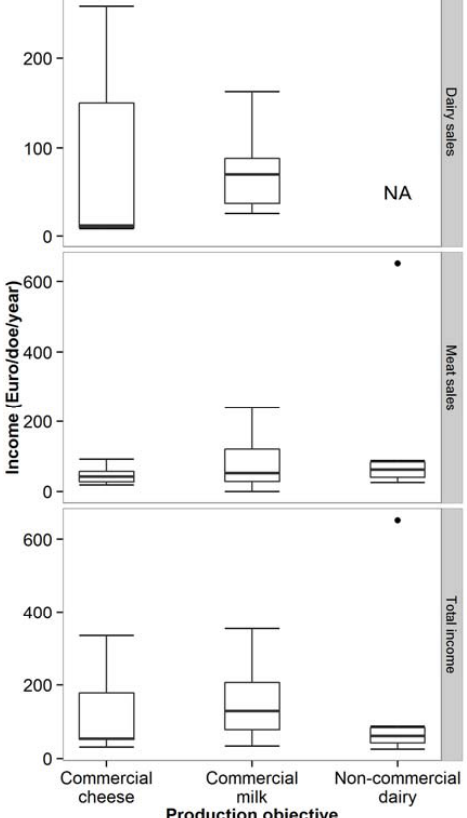
Figure 3. The annual income from dairy sales, goat sales and total annual income; on goat holdings in northern Morocco based on monthly data collections between September 2009 and August 2012. Holdings were classified by dairy production status: commercial milk, commercial cheese and non ‐ commercial dairy.